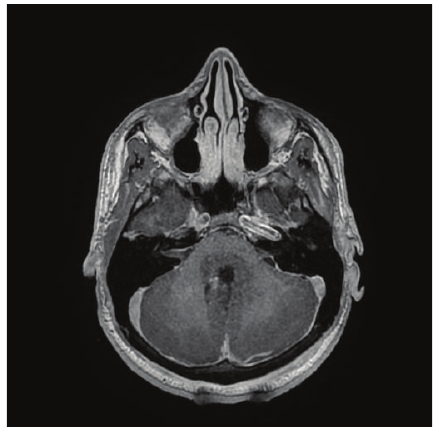
Figure 2: T1-weighted, immediate postoperative, gadolinium- enhanced axial magnetic resonance image, showing gross total resection with small enhancing changes along the posterior aspect of the surgical resection cavity.